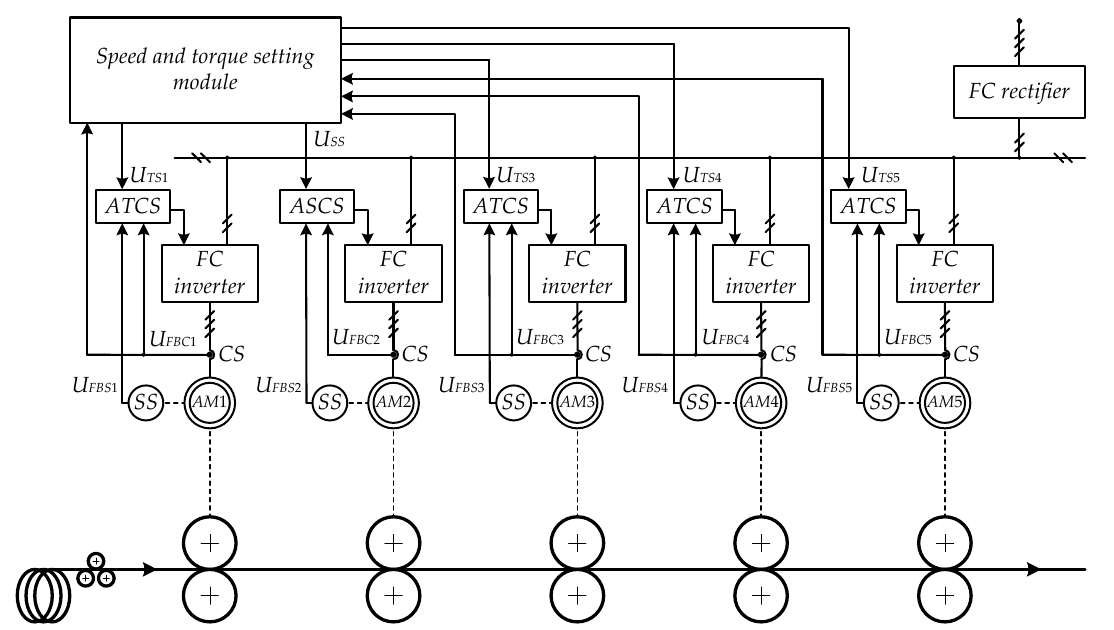
Figure 7. Functional Circuit of a Five-Stand Mill RPSACS: speed and torque setting module; fre- quency converter (FC) rectifier; automated torque control system (ATCS); automatic speed control system (ASCS); FC inverter; U FBi , U FBi -current and speed feedback voltages; CS–current sensor; AM-asynchronous motor; SS-speed sensor; U TSi -torque setting voltages.